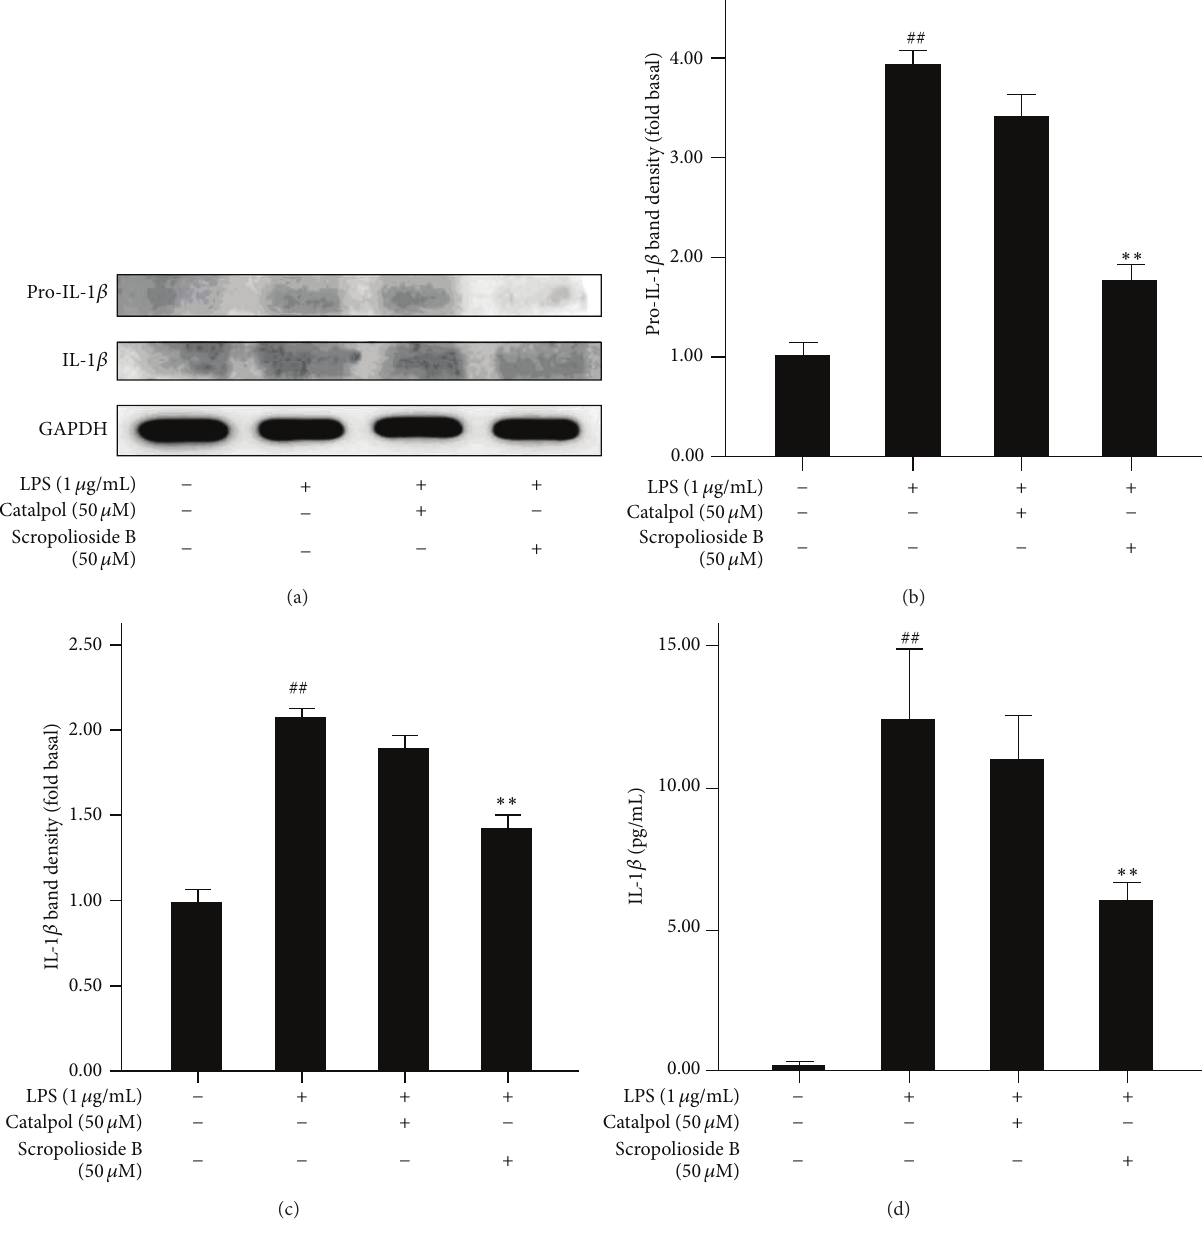
Figure 5: Scropolioside B and catalpol inhibited the expression of pro-IL-1 𝛽 and IL-1 𝛽 in LPS-induced THP-1 cells. ((a)–(d)) THP-1 cells were pretreated with 50 𝜇 mol/L catalpol or scropolioside B for 1h and then stimulated with LPS (1 𝜇 g/mL) for another 24 h. The protein expression of pro-IL-1 𝛽 and IL-1 𝛽 was measured by western blot. The levels of cytokines in the medium were measured using an ELISA kit. The data represent the mean values of over three experiments ± SD. ## 𝑃 < 0.01 compared to vehicle control, ∗∗ 𝑃 < 0.01 compared to LPS